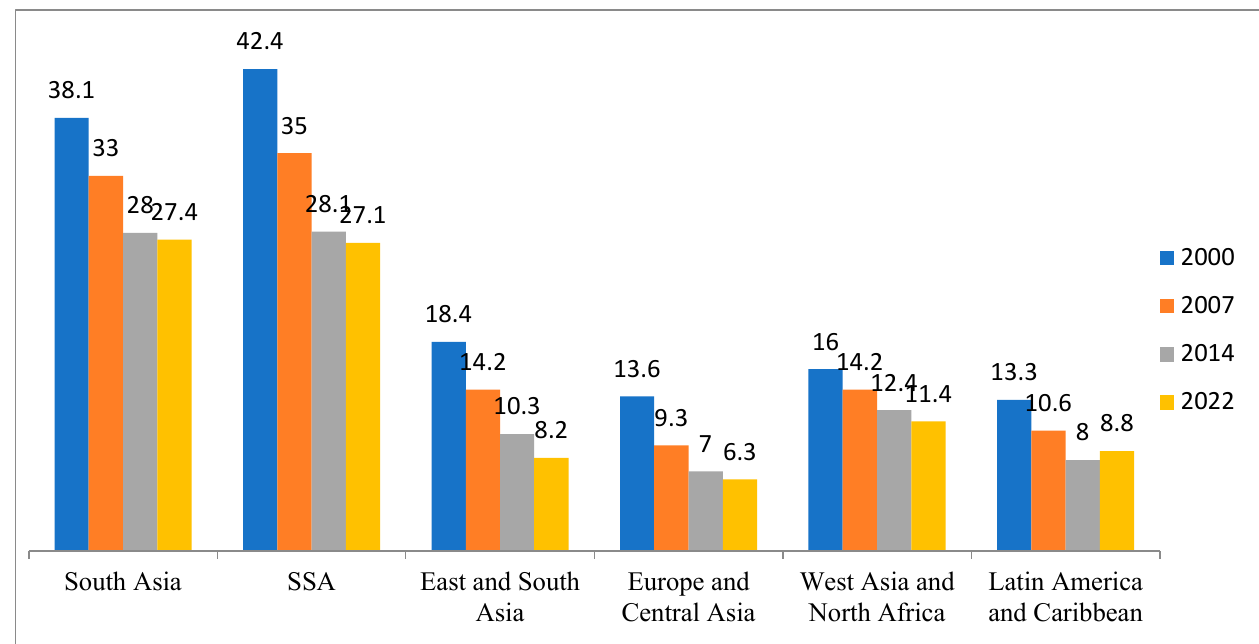
Figure 2. Regional Global Hunger Indexes in 2000 to 2022. Source: https://www.globalhungerindex.org/trends.html, accessed on 3 October 2022.